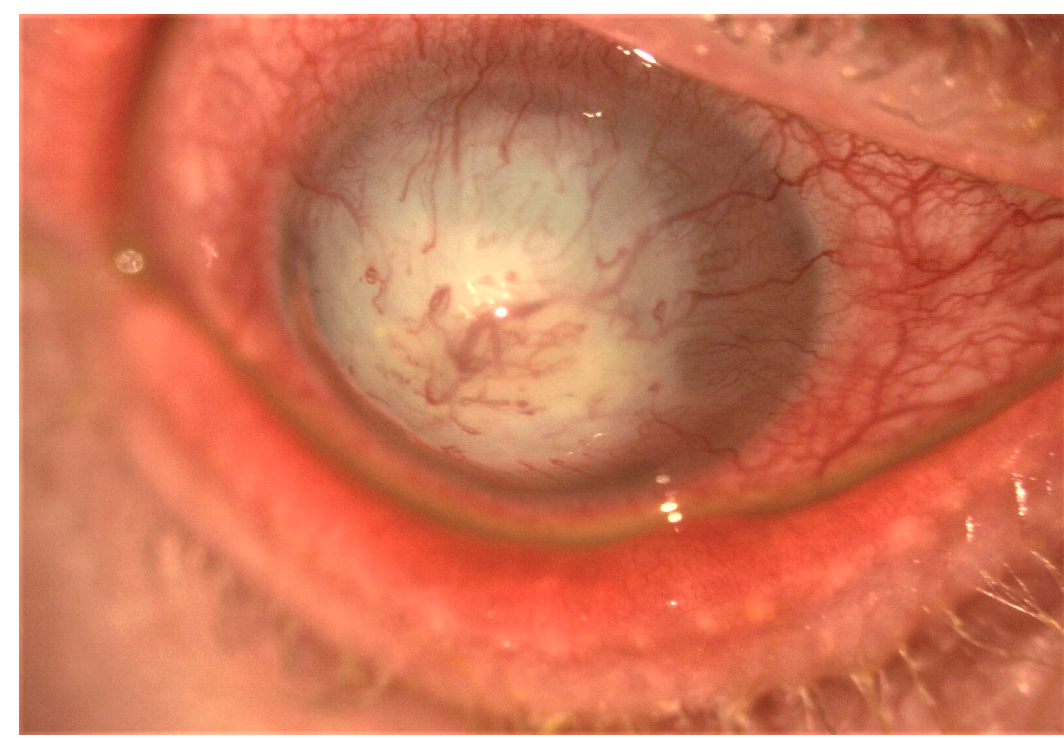
Figure 3. Slit-lamp image showing post-infectious severe corneal scarring and neovascularization.